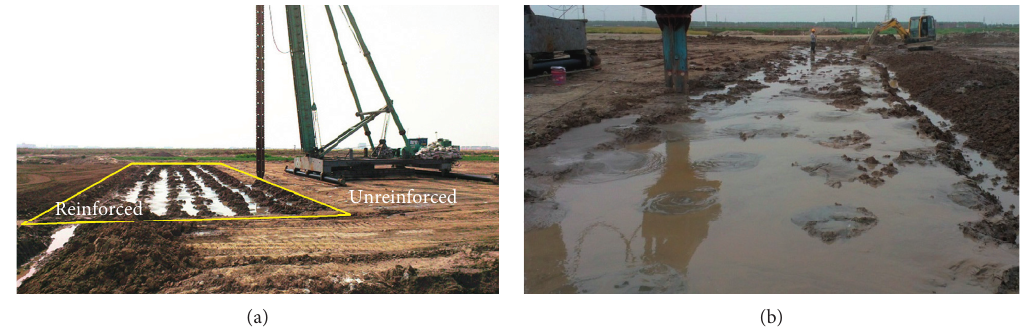
Figure 11: Foundation reinforcement effect by CSPRCM. (a) Before and after reinforcement contrast. (b) Strengthening process.